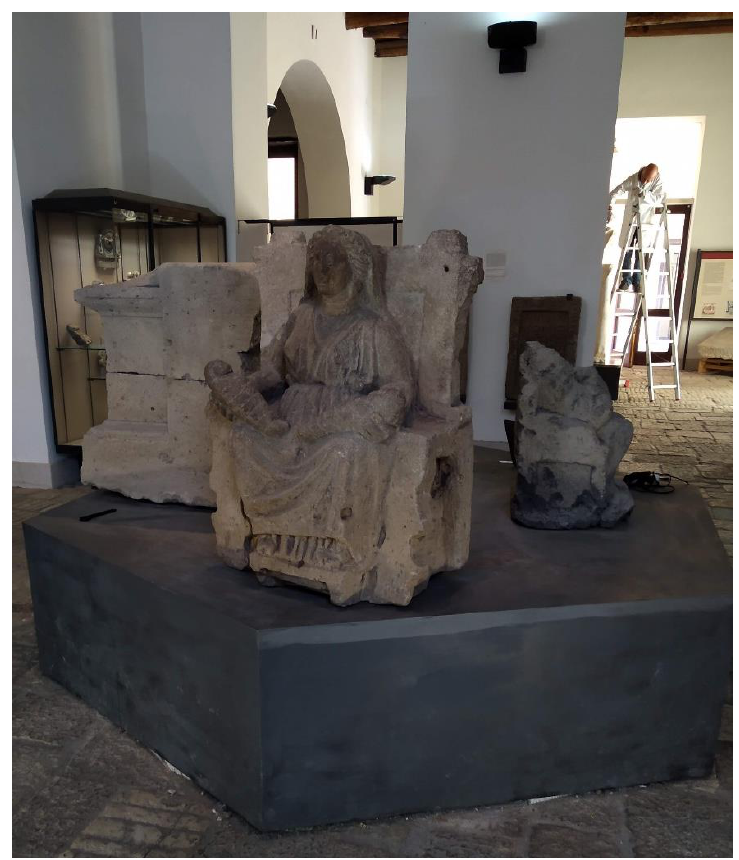
Figure 2. The Mater Matuta , Archaeological Museum of the Ancient